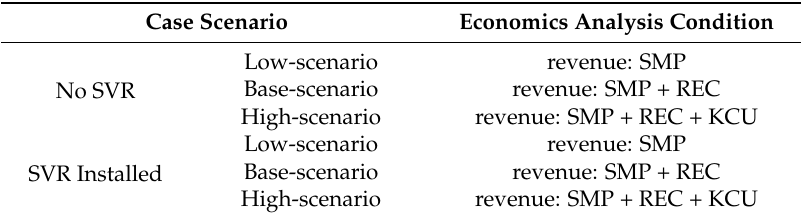
Table 4. Six scenarios for economic